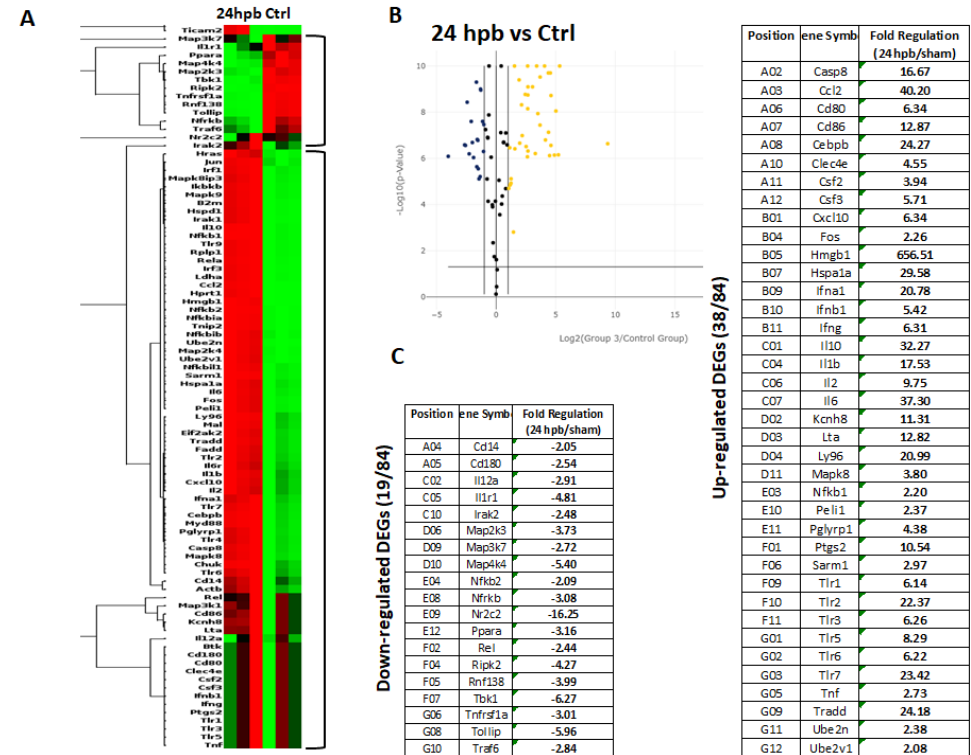
Figure 3. Expression of TLR-Related Genes in burn injury rats. Sham control or burn injury analyzed through a Rat TLR RT2 Profiler PCR Array (QIAGEN): ( A ) Heatmap displaying hierarchical clustering of the entire dataset of expressed genes and indicating co-regulated genes across sham control and burn experimental groups: healthy sham control rats—CTRL; burn injury rats—24 hpb. Clustering analysis showed that genes upregulated in burn injury rats belong to apoptosis modulation, IL-1 signaling, TLR signaling, RIG-I-like receptor signaling and IL-17 signaling pathways; ( B ) The volcano plots identify significant changes in gene expression between groups. The volcano plot displays the statistical significance ( p < 0.05) versus fold change on the y and x axes, respectively; ( C ) Venn diagram and list of TLR-related genes regulated in burn injury rats. The expression levels of